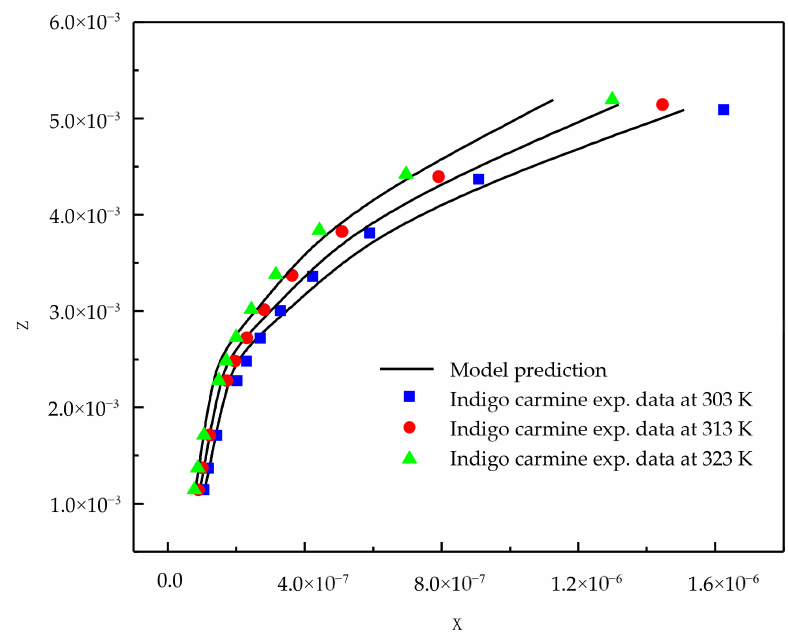
Figure 1. New model correlations for indigo carmine dye-activated carbon system at various temperatures.